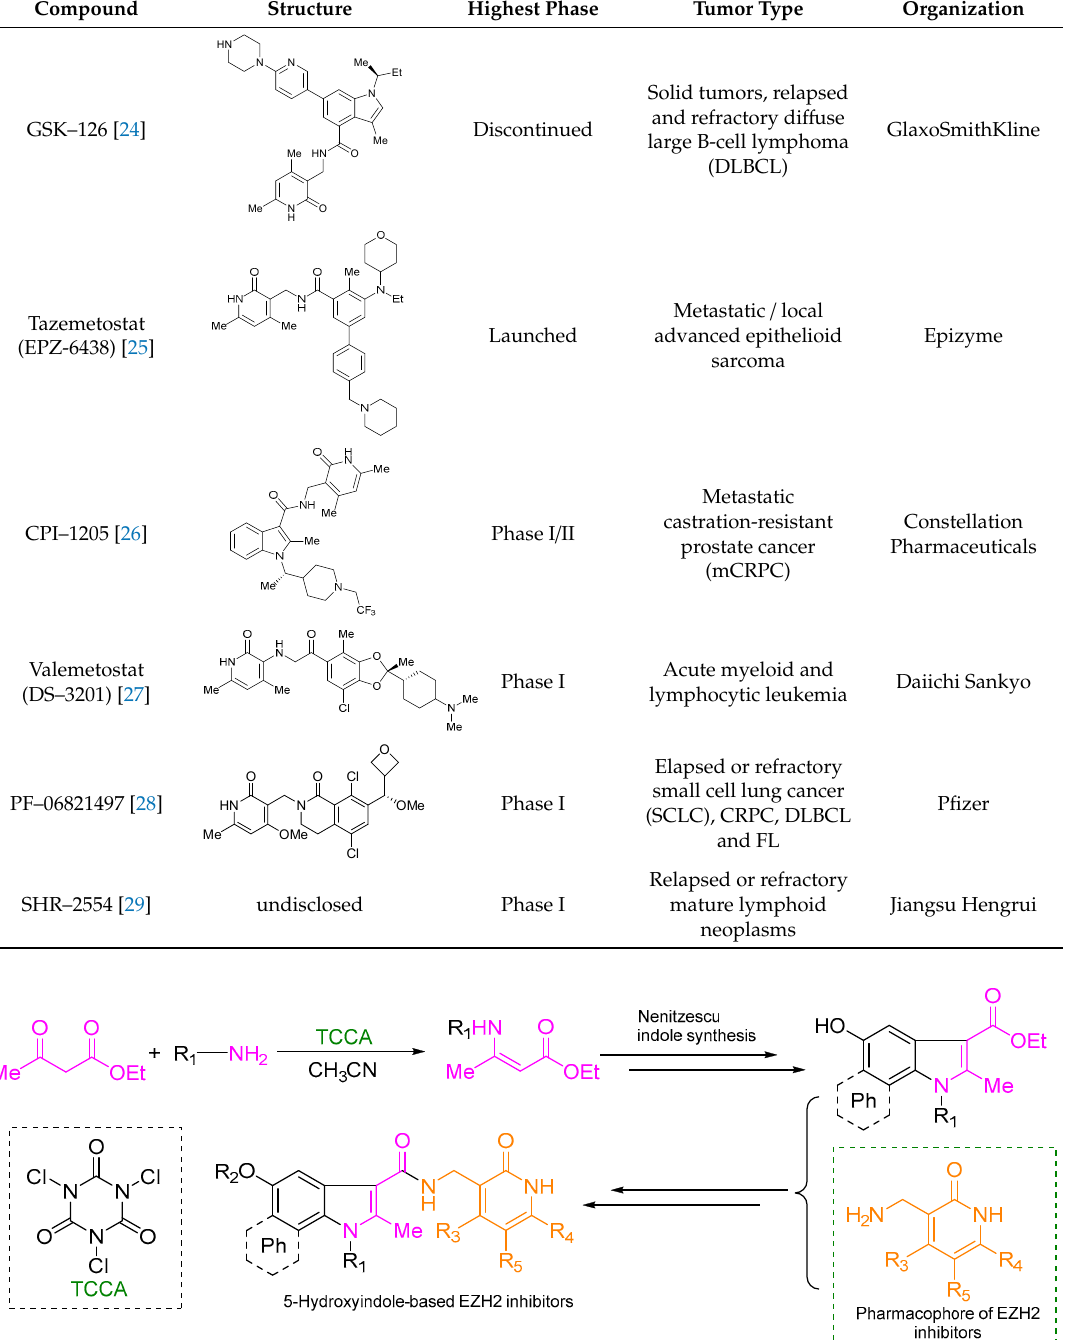
Table 1. Representative EZH2Is in clinical trials.